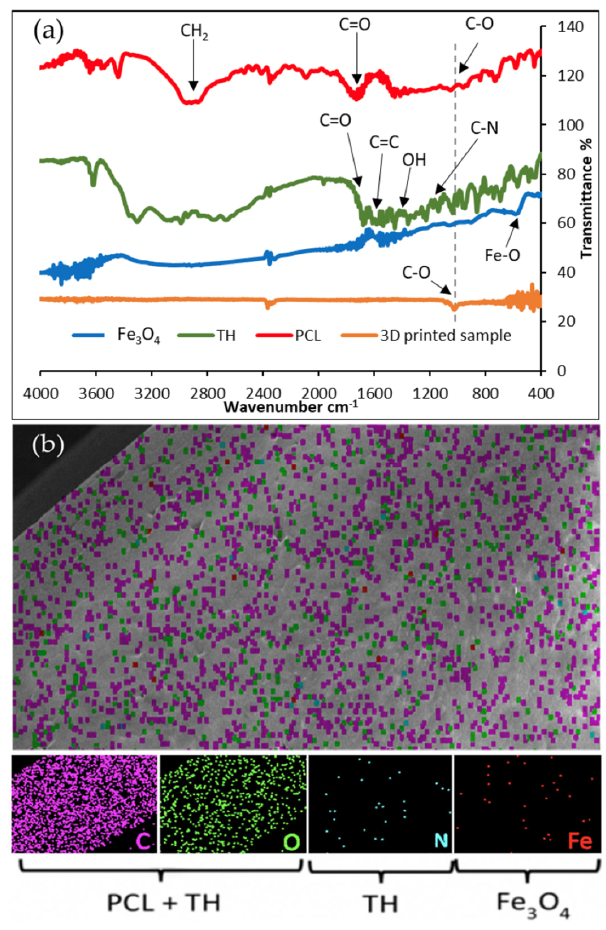
Figure 4. Characterization of samples. ( a ) FTIR of each component of the samples and 3D ‐ printed sample and ( b ) EDX of 3D ‐ printed sample.